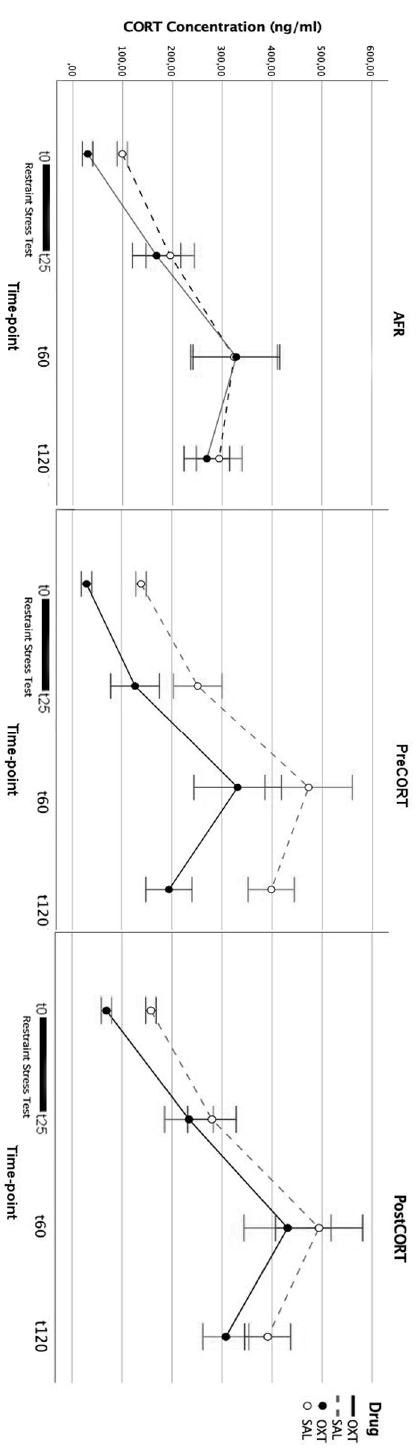
Figure 2. Plasma corticosterone concentration. Plasma corticosterone concentrations Subjects: AFR-SAL, AFR-OXT, PreCORT-SAL, PreCORT-OXT, PostCORT-SAL and PostCORT OXT ( n = 8). Blood samples were collected before a 25-min restraint stress (t0), immediately after (t25) 35 and 95 min later (t60 and t120). Subjects were administered either intranasal saline or oxytocin (20 µg/mL) 10 min before the test in a volume of 2 µL. Error bars indicate mean ± SEM.